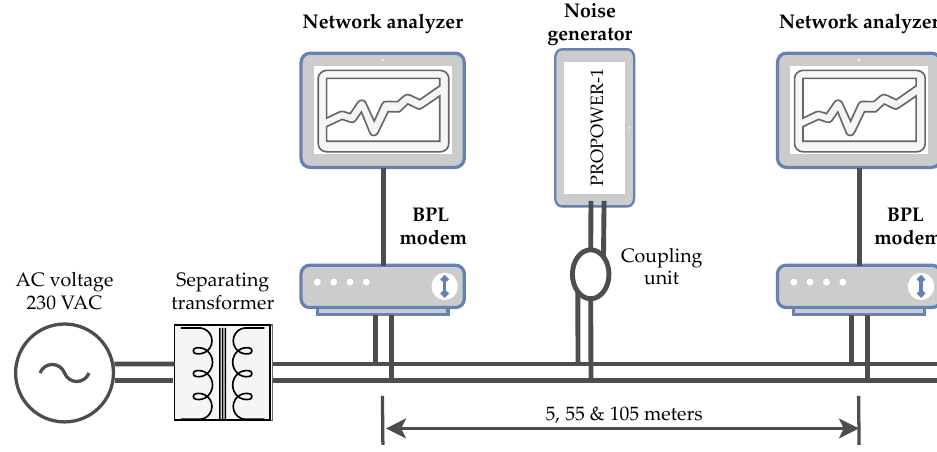
Figure 2. Topology for laboratory measurement. Table 5. Promax PROPOWER–1